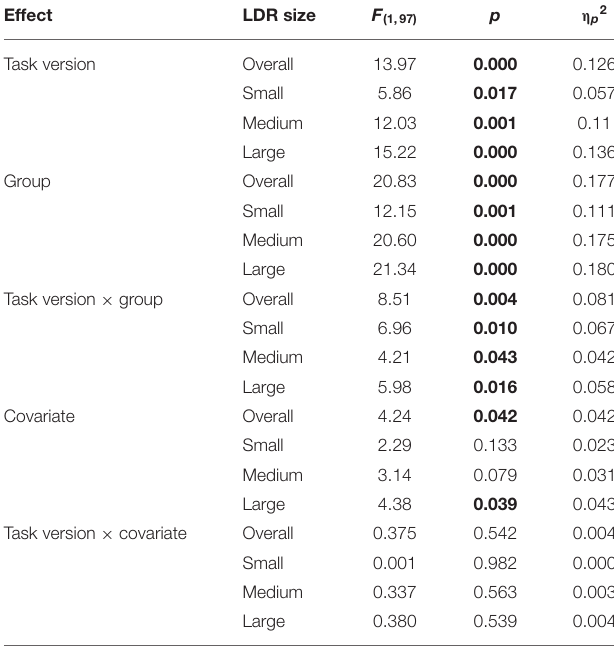
TABLE 2 | Results of the mixed ANCOVA analyses with Task version (money, surgical masks) and Group (HG, NHG) effects on discount rate ( k ) based on small, medium, large, or overall later delayed reward (LDR)